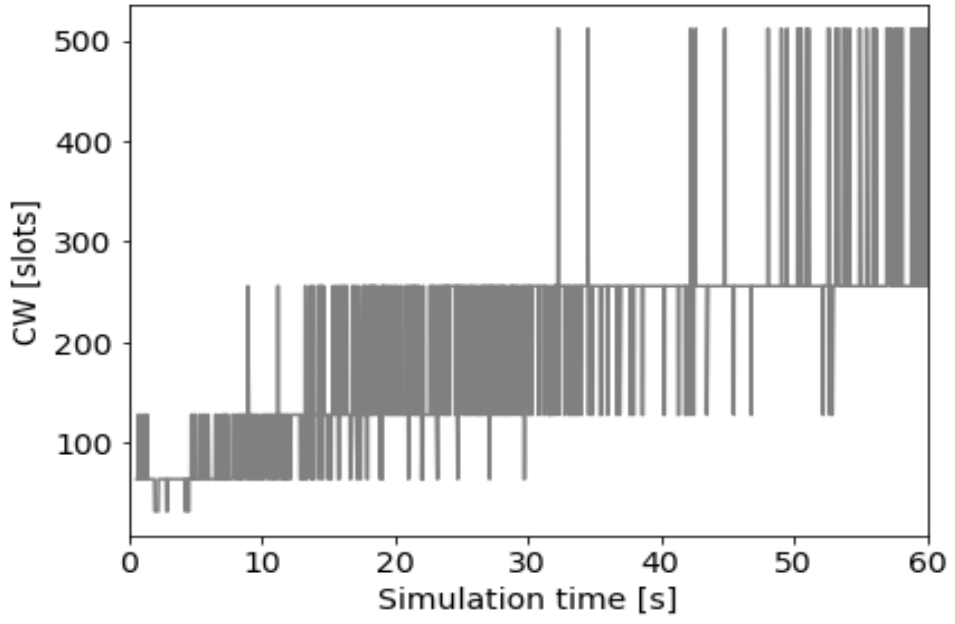
Figure 7. CW Variation by DCWO in Dynamic